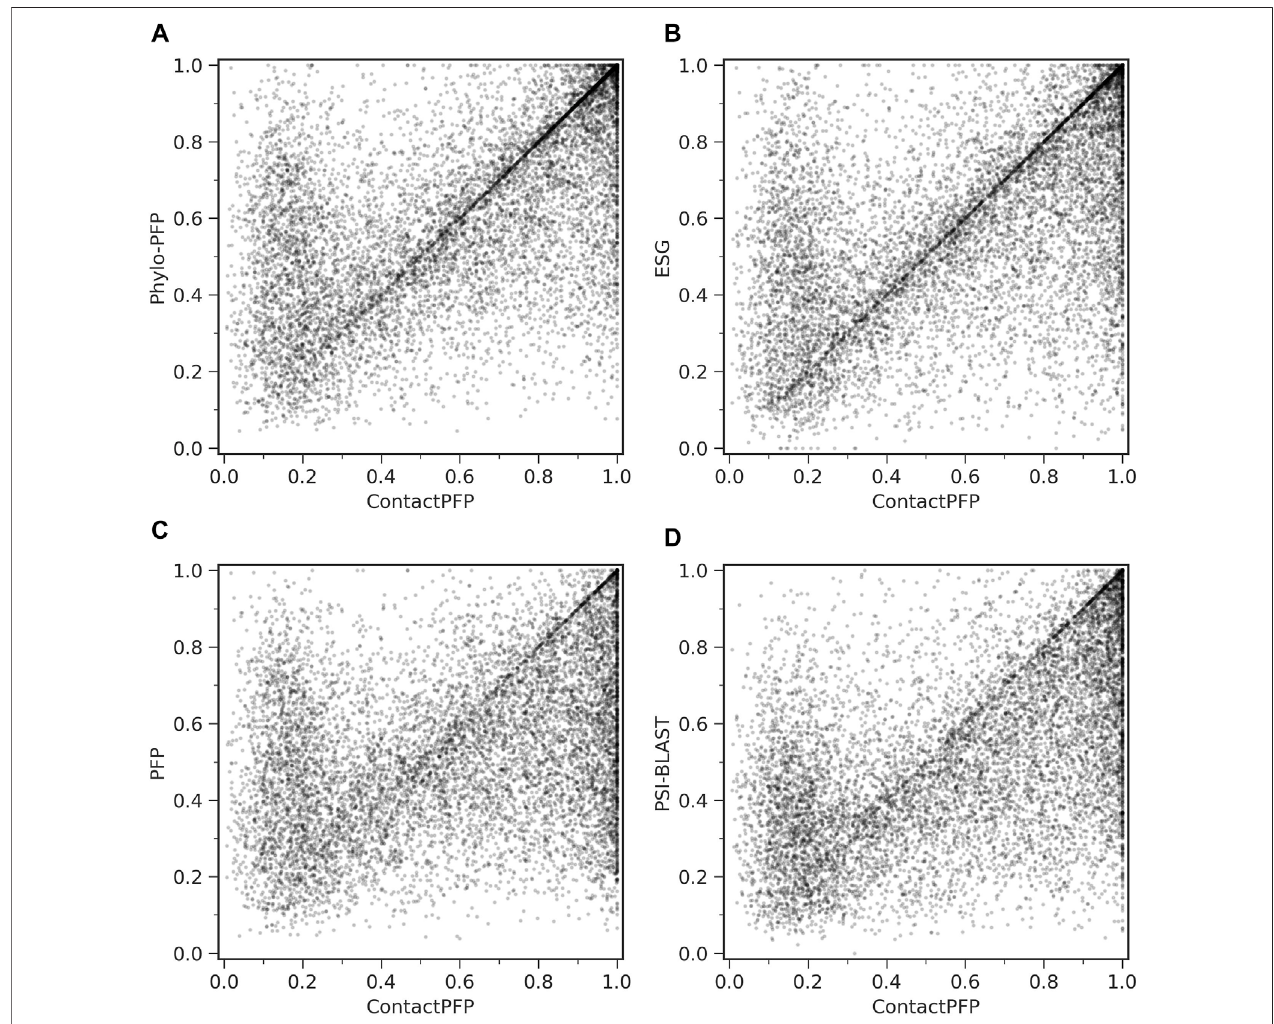
FIGURE 3 | Comparison of Fmax score of individual target proteins. To be precise, they are F-score of each protein using the score cutoff that yielded the Fmax score of the benchmark dataset. Each point represents a protein in the benchmark dataset. (A) Comparison between ContactPFP and Phylo-PFP; (B) Comparison between ContactPFP and ESG; (C) comparison between ContactPFP and PFP; (D) Comparison between ContactPFP vs.